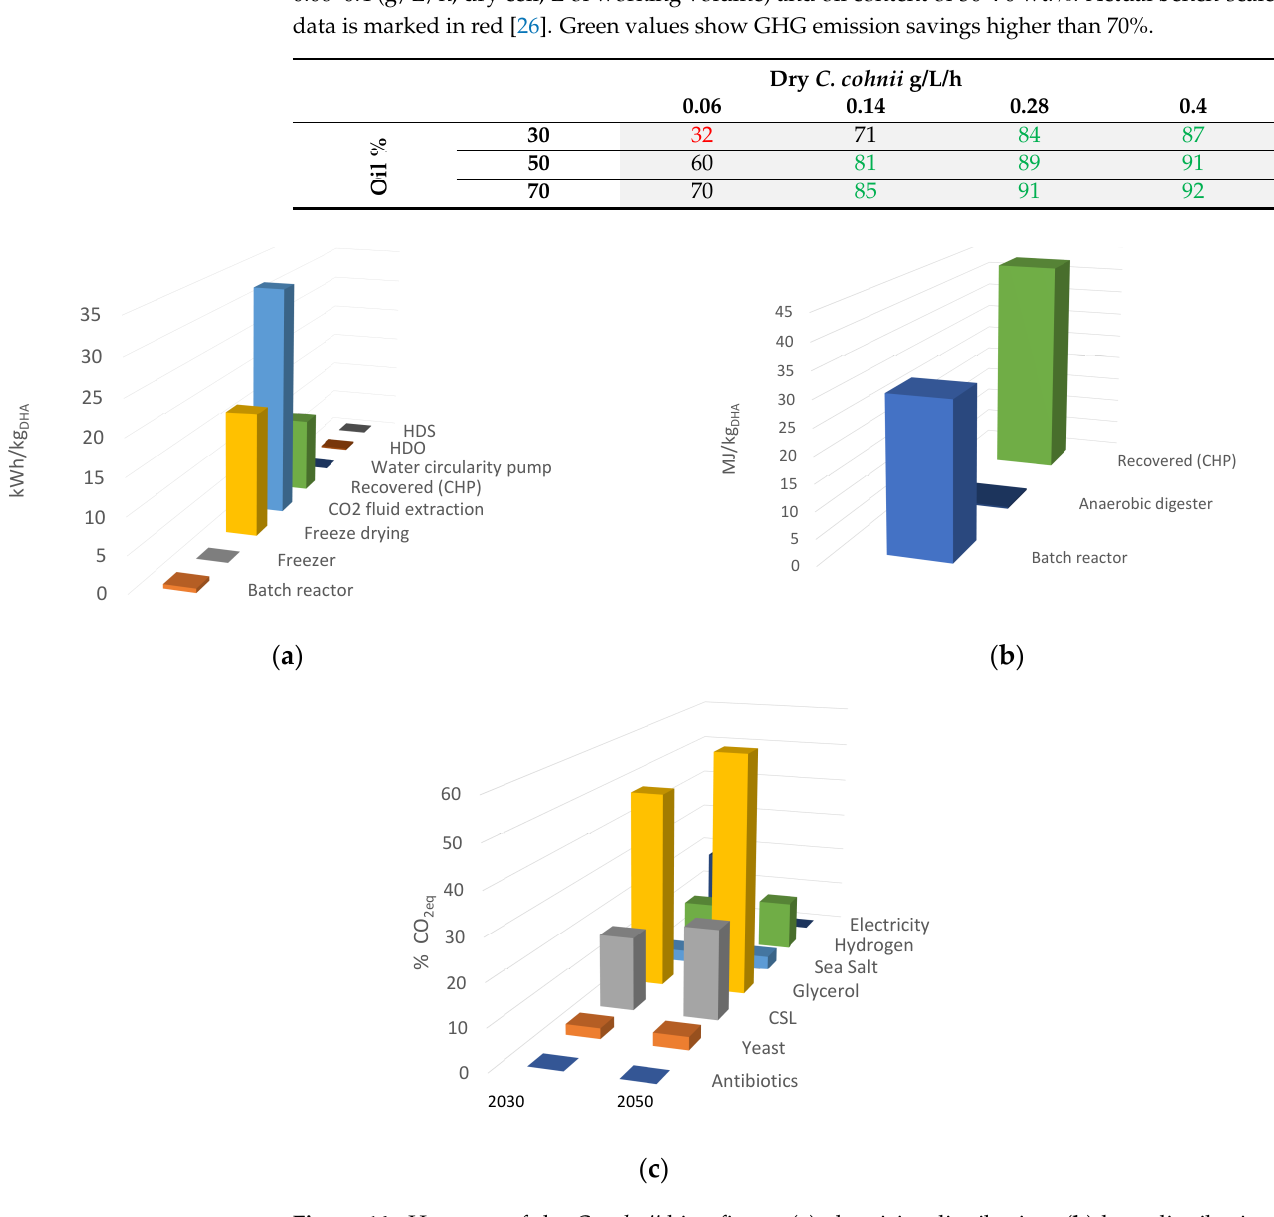
Figure 14. Hotspots of the C. cohnii biorefinery, ( a ) electricity distribution, ( b ) heat distribution, ( c ) GHG distribution in 2030 and 2050.